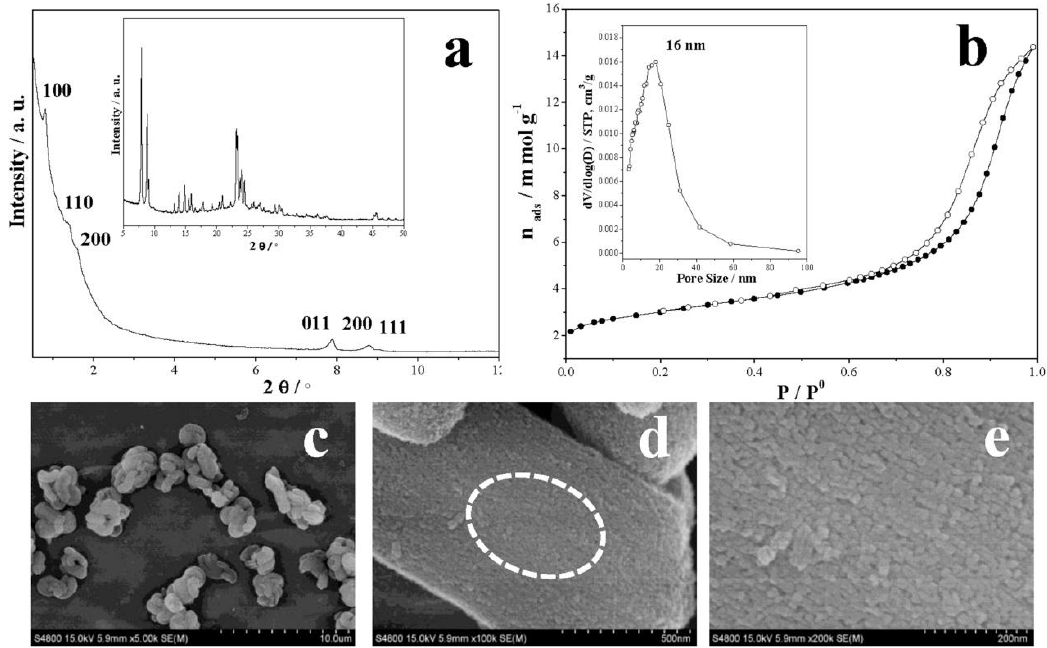
Figure 16. XRD, N 2 -adsorption, and SEM results for ordered mesoporous ZSM-5 nanoparticle aggregates (ZNA) by controlling the arrangement of nanoparticles. ( a ), XRD pattern; ( b ), N 2 adsorption-desorption; ( c – e ), SEM images [107]. Copyright Elsevier, 2016.